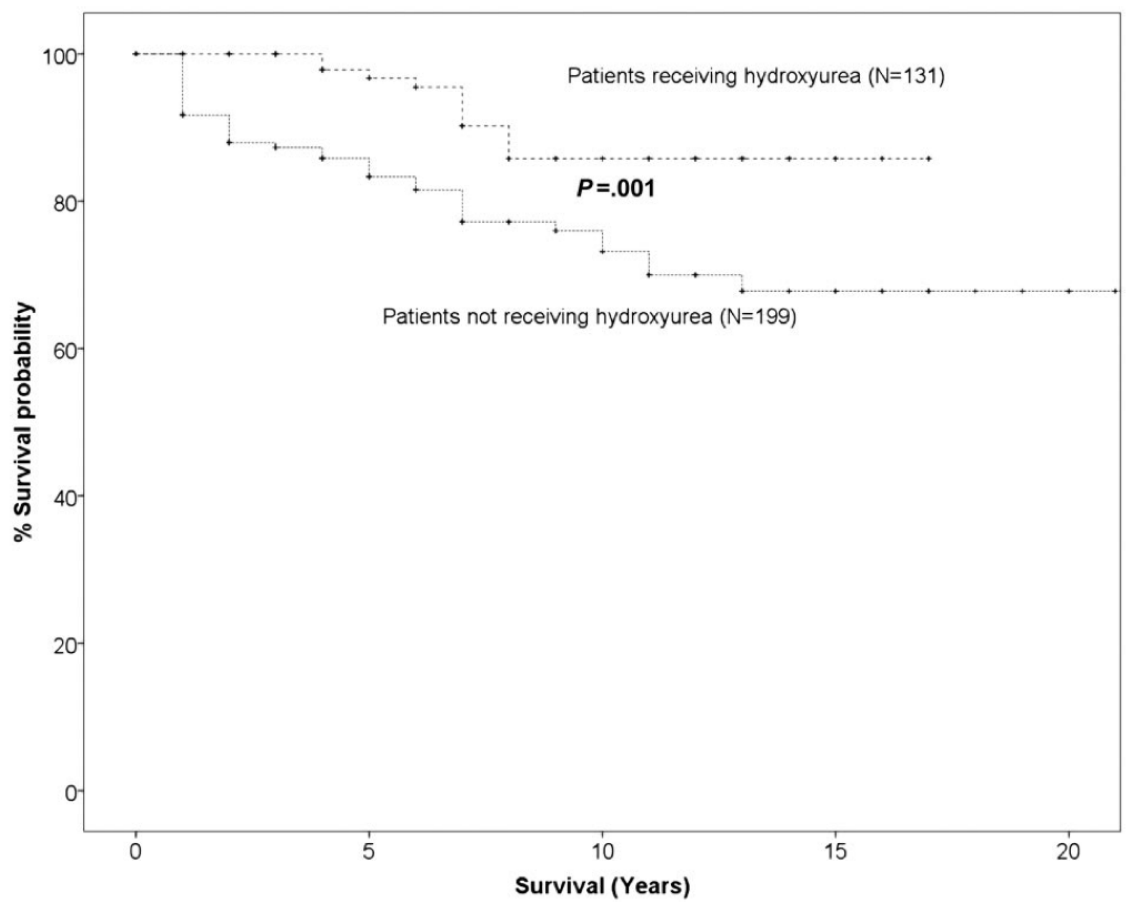
Figure 2. Probability of 10-year overall survival in HU SCD patients versus non-HU SCD patients (adapted from [10]).